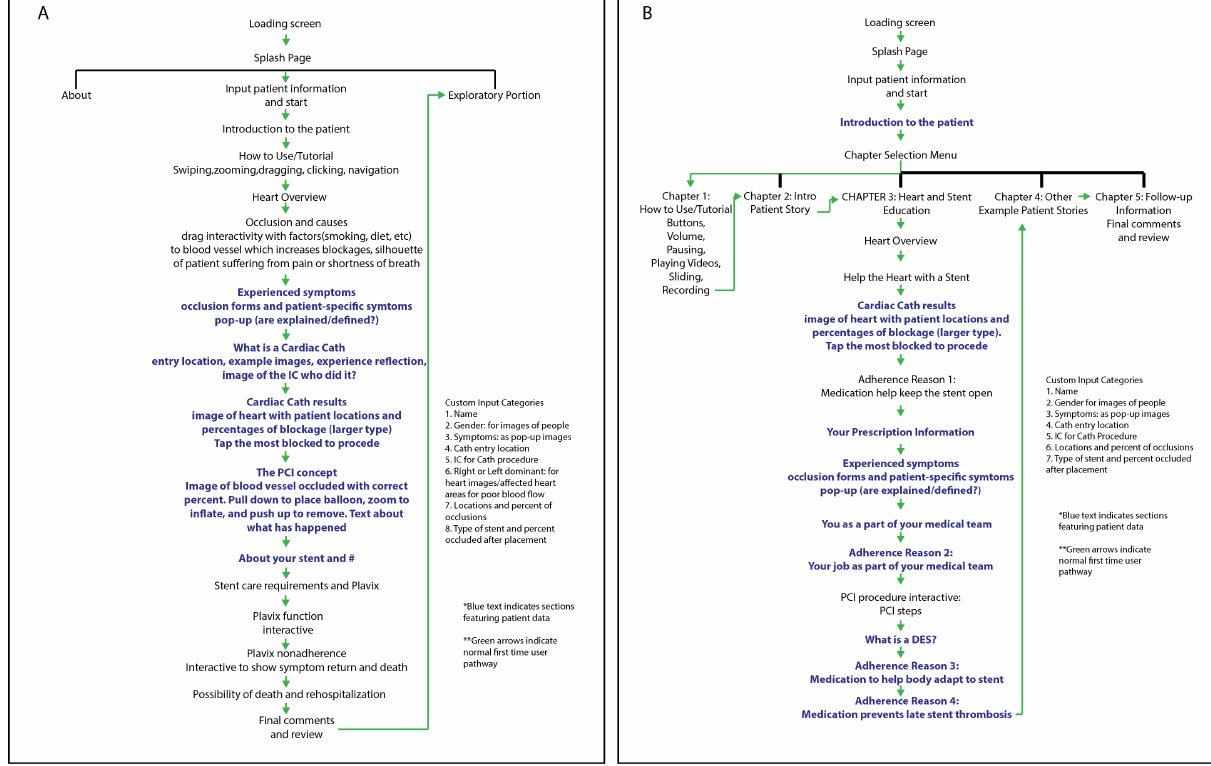
Figure 3. Outlines of the My Interventional Drug-Eluting Stent Educational App learning module. (A) Initial outline. (B) Revised outline based on feedback and closer adherence to Kolb’s